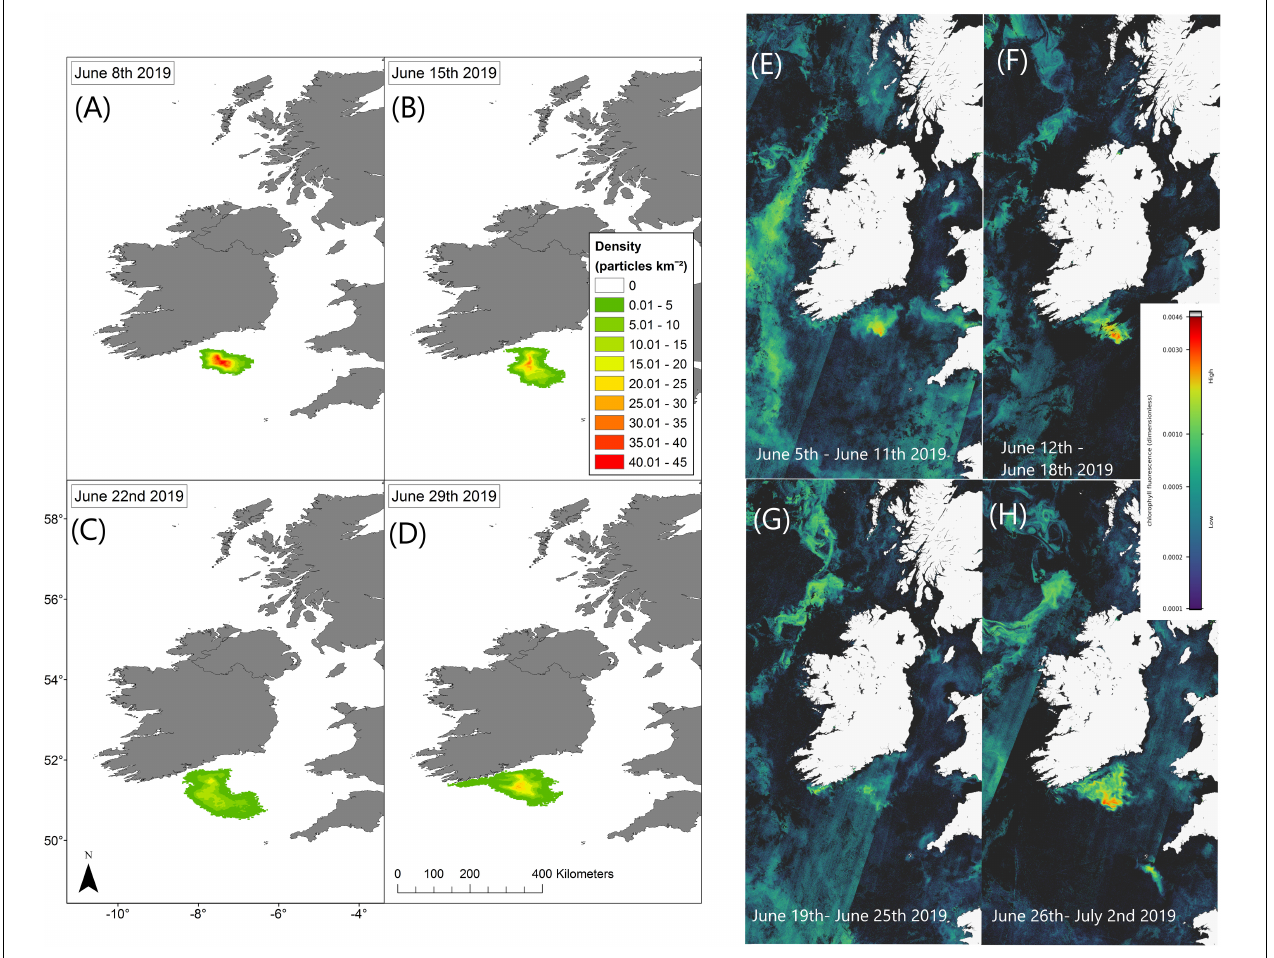
FIGURE 4 | Particle tracking model simulation results display current driven bloom dispersal on the left (A–D) . Maps show the density distribution of particles on 08/06/2019, 15/06/2019, 22/06/2019, and 29/06/2019 compared with Sentinel-3a OLCI images with RBD weekly composites on the right (E–H)